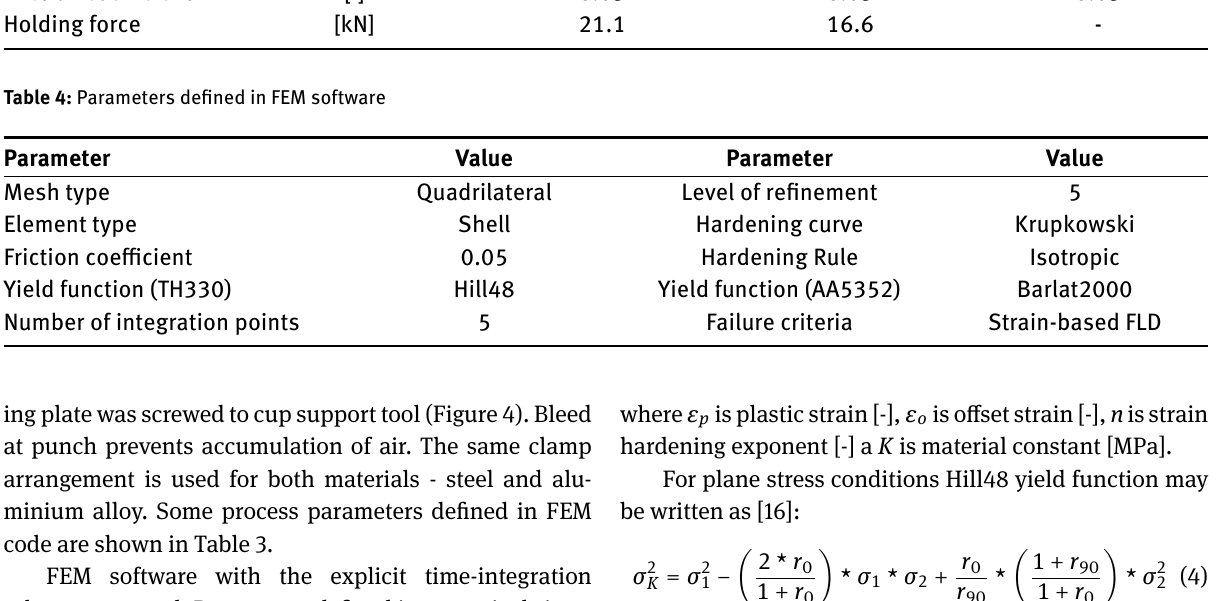
Table 3: Parameters defined in Pam-Stamp 2G software Drawing speed Friction coeflcient Holding force